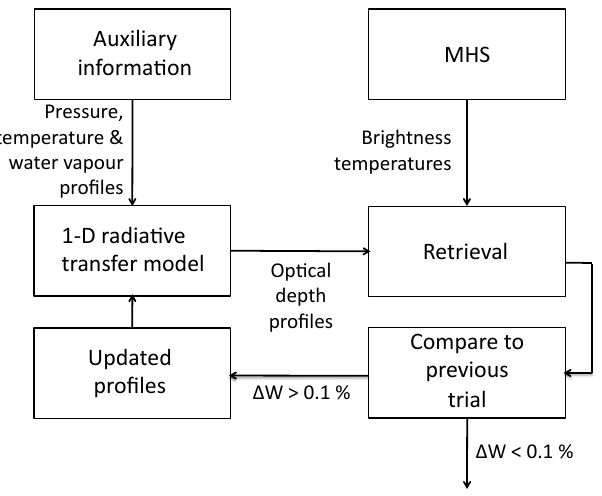
Figure 1. PLDC16 retrieval flow chart. The retrieval starts with aux- iliary temperature, pressure, and water vapour profiles as input to a 1-D radiative transfer model. Optical depth profiles are produced for each channel. These are used together with satellite brightness temperatures and Eqs. (2), (6) and (7) to retrieve the scaling factor x n for each trial n . x n is used to scale the trial water vapour profile through Eq. (9) and produce a water vapour column using Eq. (10). If the change (cid:49)W in the water vapour column between trials is greater than the threshold then the scaled water vapour column is used in the next trial. The process is repeated until convergence is achieved.